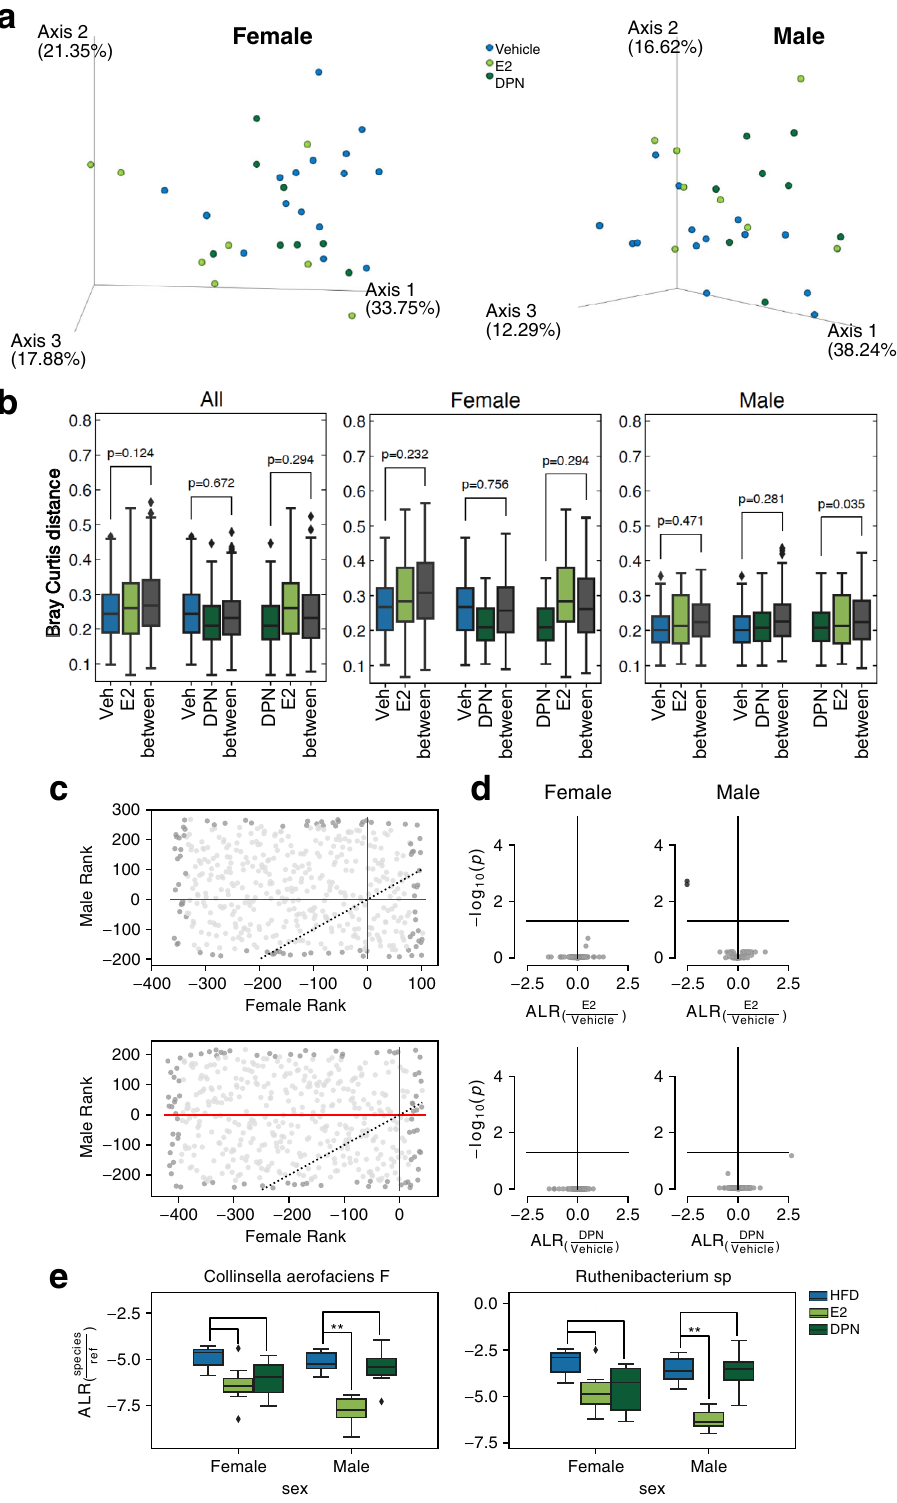
Fig. 3 Impact of estrogen treatments on the microbiota composition. a PCoA plot visualizing the beta diversity with Bray – Curtis distance in females ( n = 24) and males ( n = 24) on an HFD treated with vehicle, E2, and DPN. b Boxplots presenting the signi fi cance of the beta diversity between corresponding groups (all HFD), with Bray – Curtis distance. c Scatter plots of the microbial rank in males against the microbial rank in females upon treatment with E2 (upper panel) or DPN (lower panel). The lower right corner indicates the top-ranked species in both sexes upon E2 and DPN treatment, respectively. d Volcano plots show a degree of alteration of species by E2 and DPN treatment in both sexes. e Boxplot of the additive-log-ratio transformed taxa showing the signi fi cantly altered species by E2 and DPN treatment in both sexes ( n = 8 per group). The boxplots are shown as median (line), interquartile range (box), and minimum to maximum data range (whisker). ** FDR < 0.01 (Benjamini –